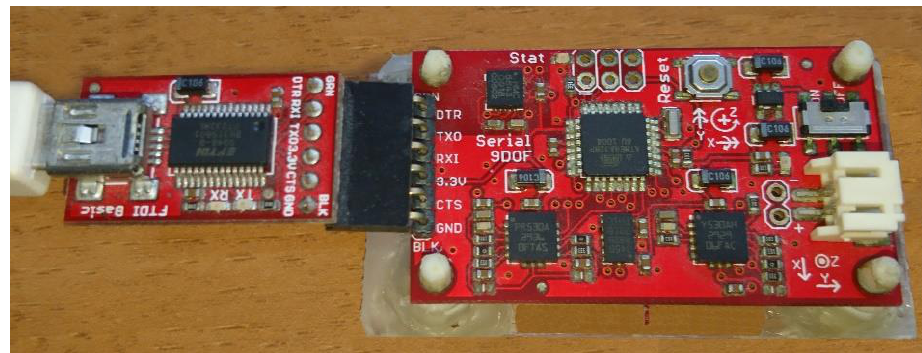
Figure 5. Low-cost microelectromechanical systems (MEMS) strap-down sensor system, SparkFun Razor 9DOF, with a serial-to-USB adapter mounted on an improvised basis.